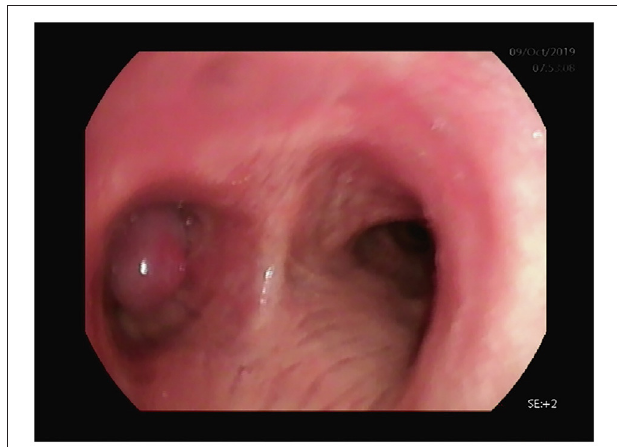
FIGURE 2 | Bronchoscopy examination revealed a left main bronchus embolism by a sarcomatoid mass. dangerous complication of EBM, is also its least common. The patient underwent a radical left pneumonectomy to resection the lesion and distal lung tissue. No metastasis was found on PET–CT after the left pneumonectomy. The patient’s 6-min walk distance was 350 meters.